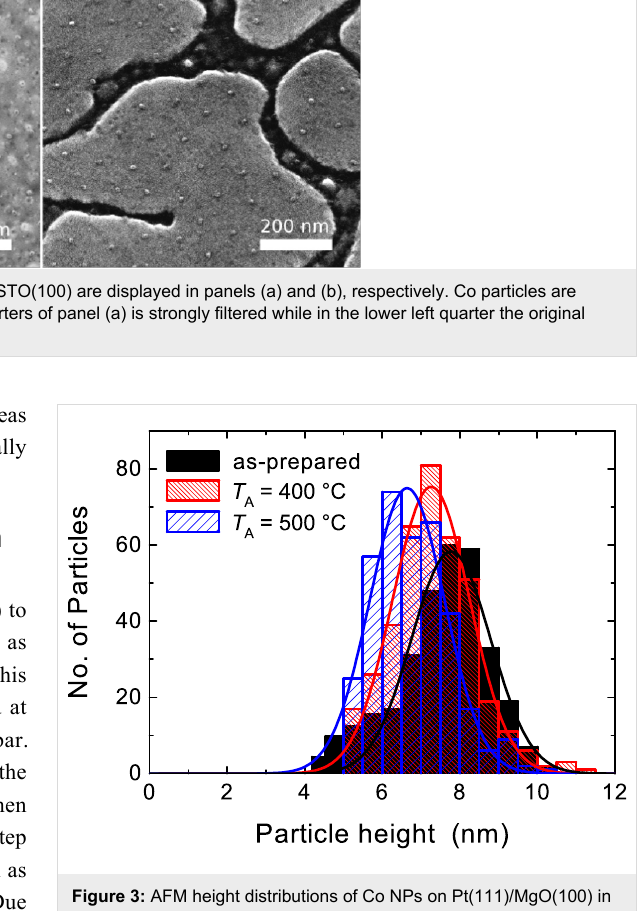
Figure 3: AFM height distributions of Co NPs on Pt(111)/MgO(100) in the as-prepared state and after annealing at T A = 400 °C and 500 °C for 30 min. Additionally, the Gaussian fits to the measured size distrib- utions are shown. Note that the particles are oxidized when examined ex-situ by